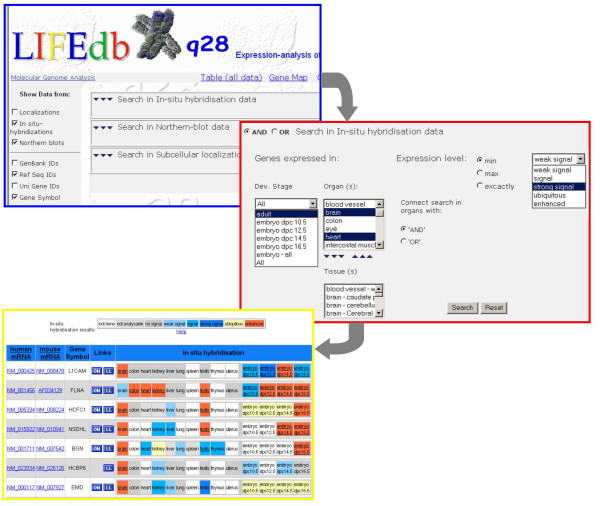
Web-accessible database. The user interface provides comprehensive query options enabling specification of different kinds of experimental data, various organs and tissues as well as signal intensities. The query results are presented in a table with a colour code for signal intensities.